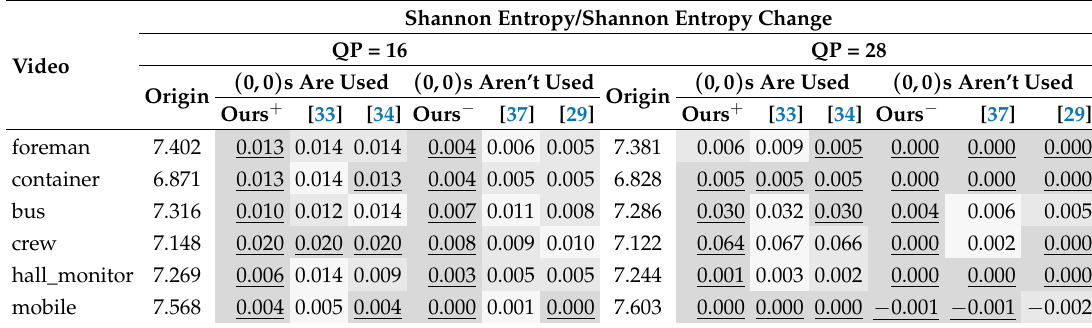
Table 8. Shannon entropy of each cover video and changes in Shannon entropy of the marked video generated by different